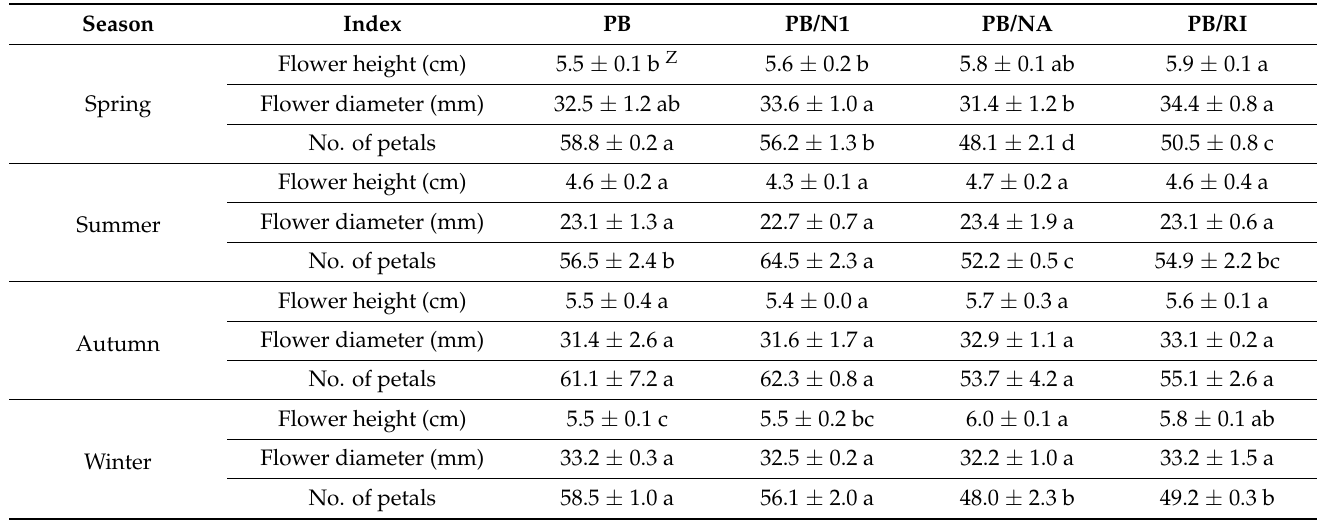
Figure 10. The yield for scion cut rose Rosa hybrida cv. Pink Beauty (PB), rootstock of Rosa multiflora cv. Hort No 1 (N1), rootstock of Rosa canina cv. Natal brier (NA), rootstock of Rosa indica cv. Major (RI), PB grafted onto N1 (PB/N1), PB grafted onto NA (PB/NA), PB grafted onto RI (PS/RI). Vertical bars are standard deviations ( n = 15). Small letters at the data points indicate mean sep-aration between the values by Duncan’s multiple test at p = 0.05. Table 4. Flower characteristics of one scion and three grafted plants.